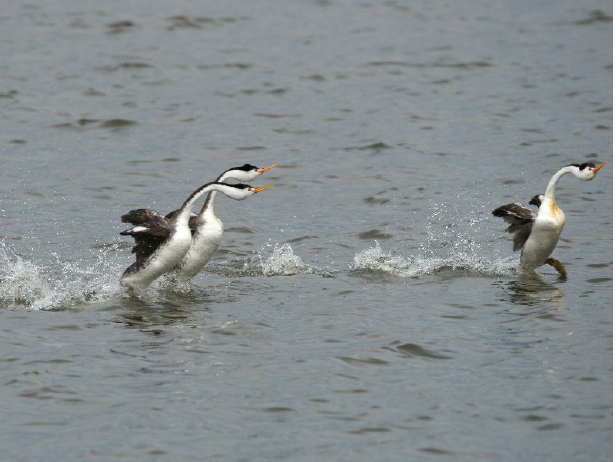
Figure 2. Courtship of Aechmophorus clarki showing that the water-running (rushing) behavior is performed by several animals together (photograph courtesy of A. Konter).